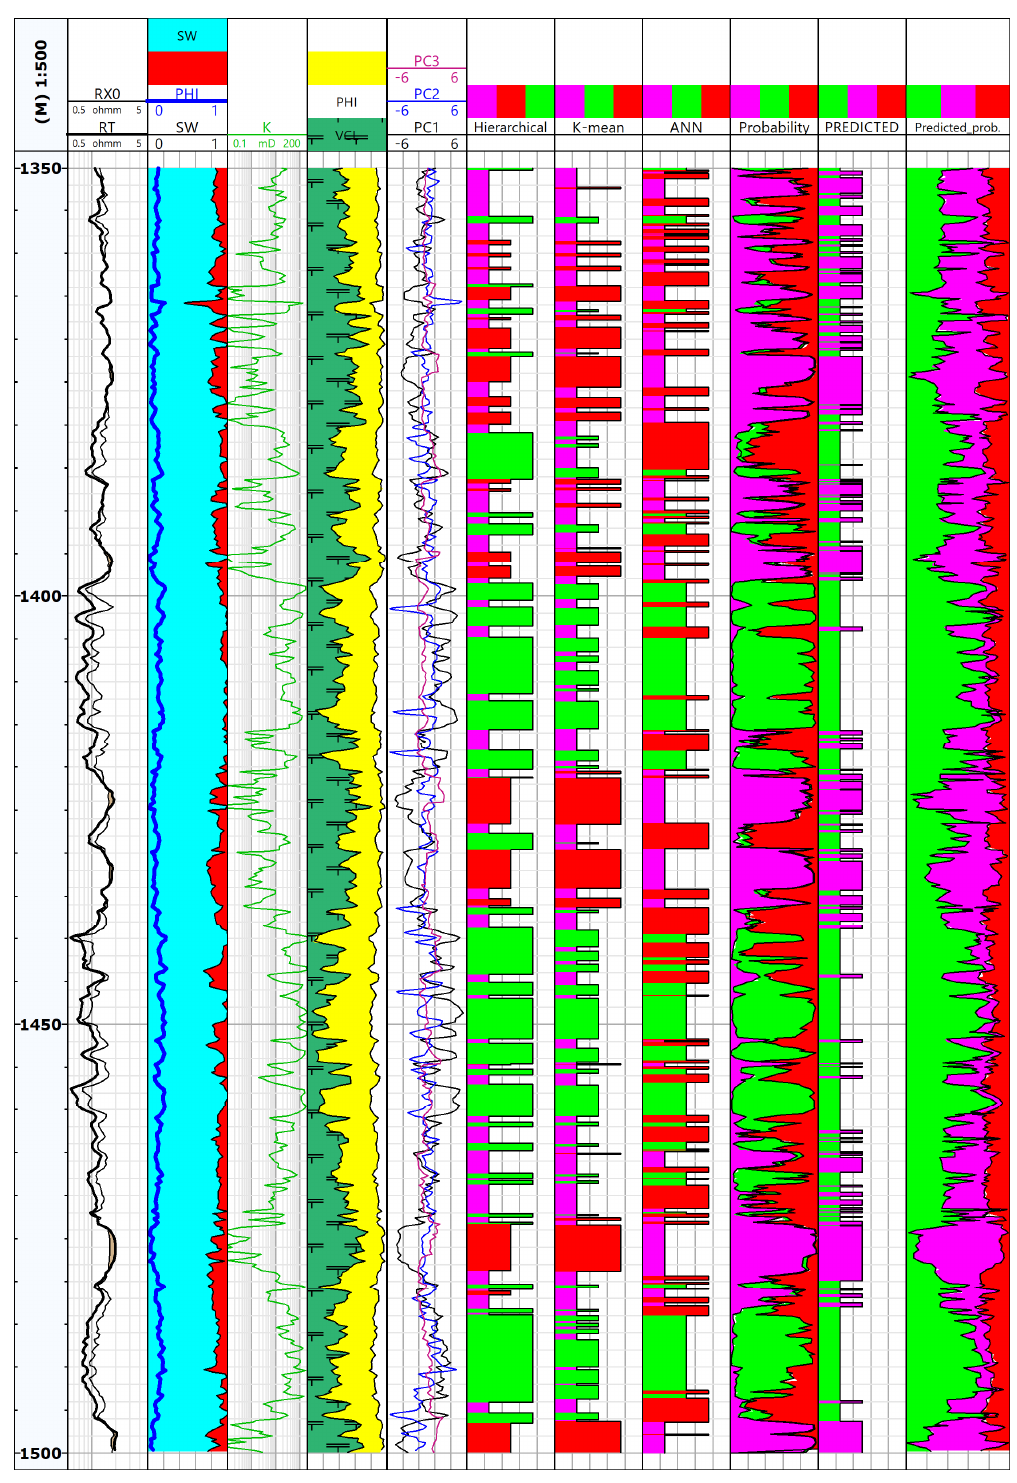
Figure 5. Results of measured log (1 track), standard comprehensive well log data interpretation (track 2–4), results of calculations (track 5–9) and results of prediction (track 10–11), W-2 well. Colours for facies identification: A–violet, B–green, C–red.